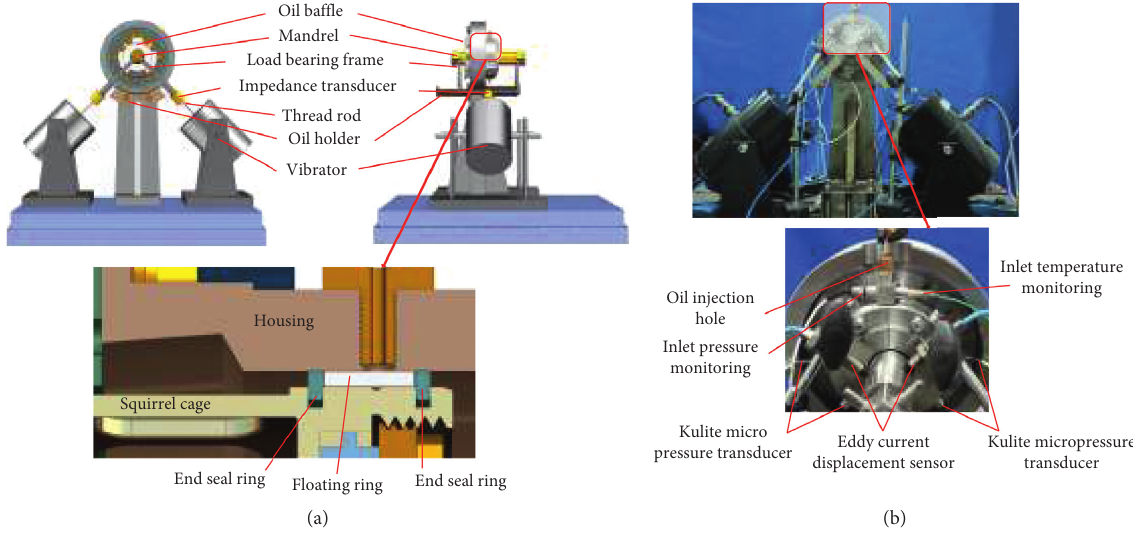
on unbalance response of the rotor-DCSFD system. 1